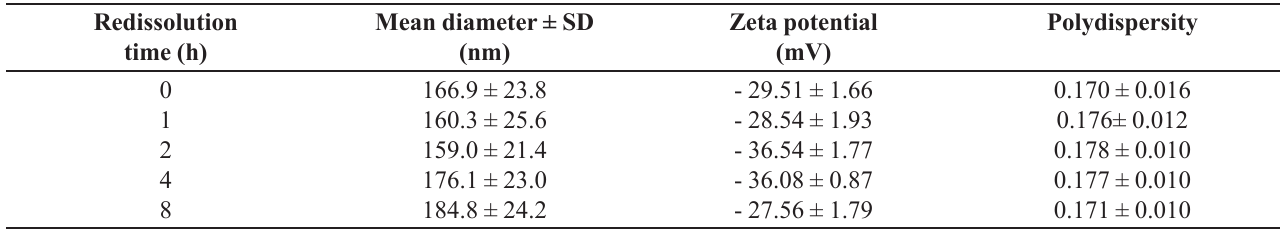
TABLE I - Particle size, zeta potential and polydispersity index changes of DTX-BIO-BSA-NPs over 8 hours Redissolution